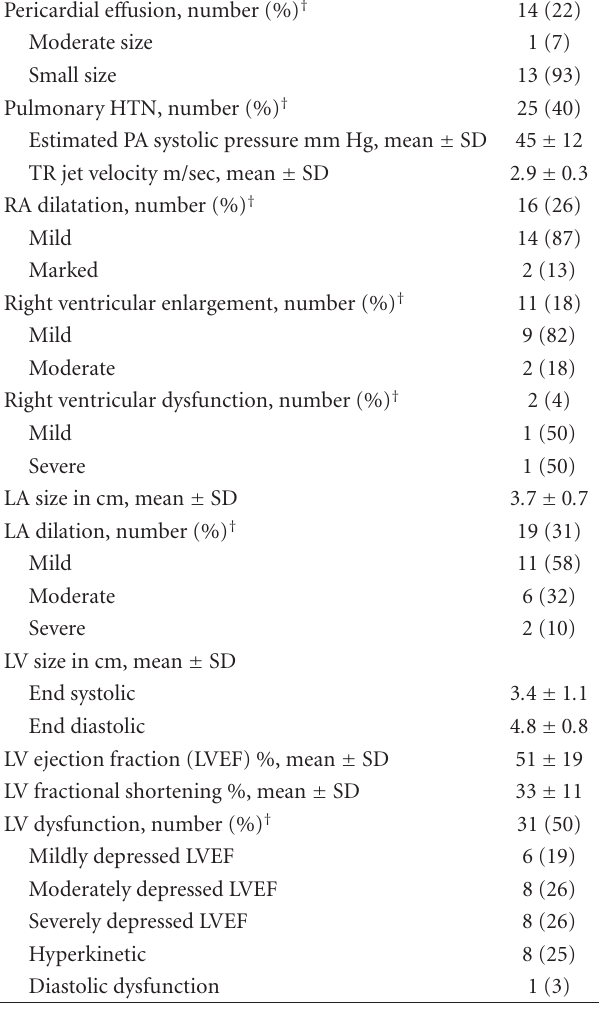
Table 3: Echocardiogram findings.